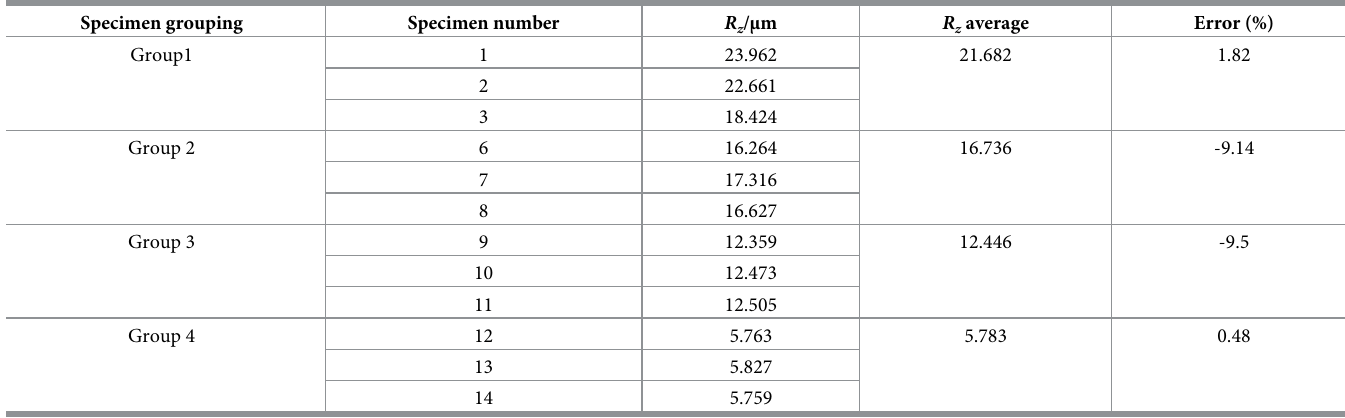
of specimens observed by microscope. z